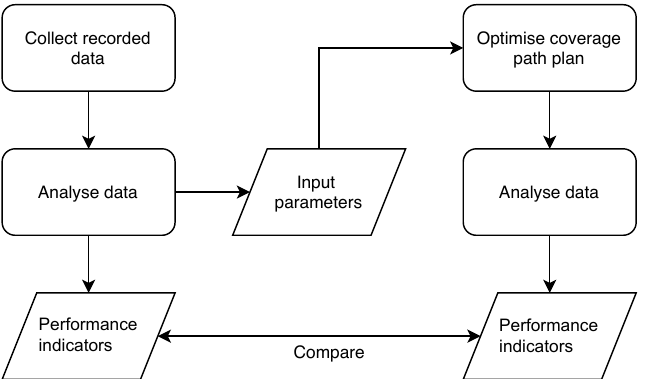
Figure 1. Flow diagram of the data analysis and comparison between the recorded and simulated data derived from the developed coverage path planning method. Input parameters to the coverage path planning method were derived from recorded data and provided the capacity and constraint parameters for the PU and